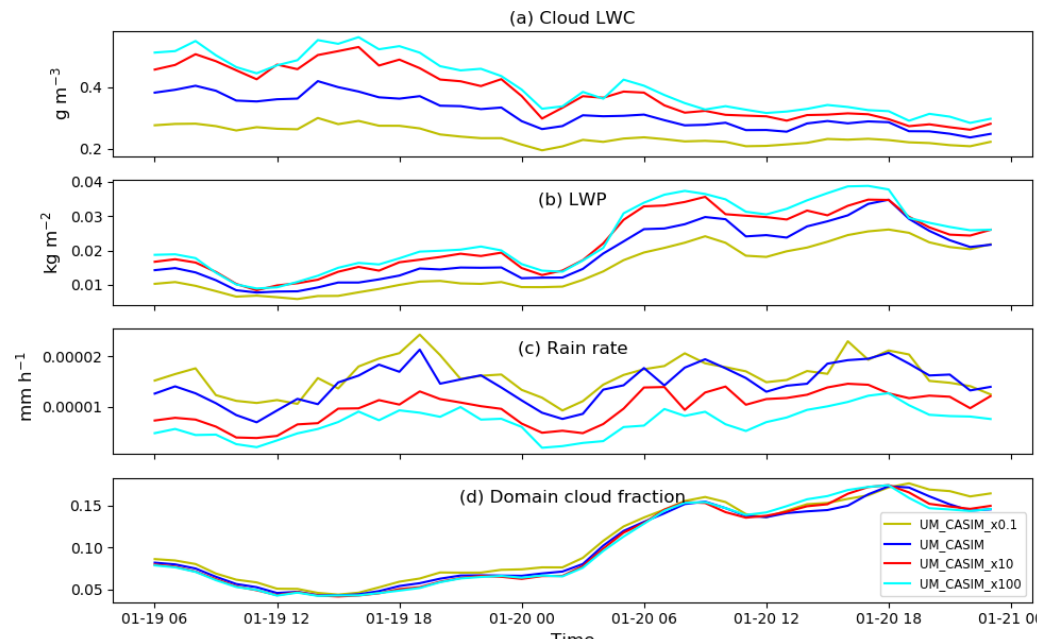
Figure 5. Time series of domain-averaged (a) cloud liquid water content (in-cloud only), (b) liquid water path (LWP), (c) rain rate, and (d) cloud fraction. A liquid water content threshold of 0.01gm − 3 is used to define a cloudy grid box.